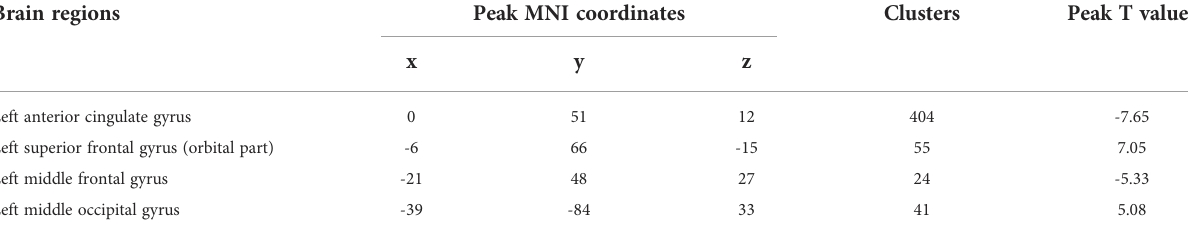
CRC, colorectal cancer; HCs, healthy controls. fALFF, fractional amplitude of low-frequency fl uctuation. MNI, Montreal Neurological Institute; x, y and z, the coordinates of peak voxel of eachclusterintheMNIspace.Thesigni fi cancethresholdwassetatP<0.05(voxel-levelwassetatP<0.001andcluster-levelwassetatP<0.05;twotailed;thecorrespondingminimumcluster size was 21 voxels) for multiple comparisons using Gaussian Random Field (GRF)